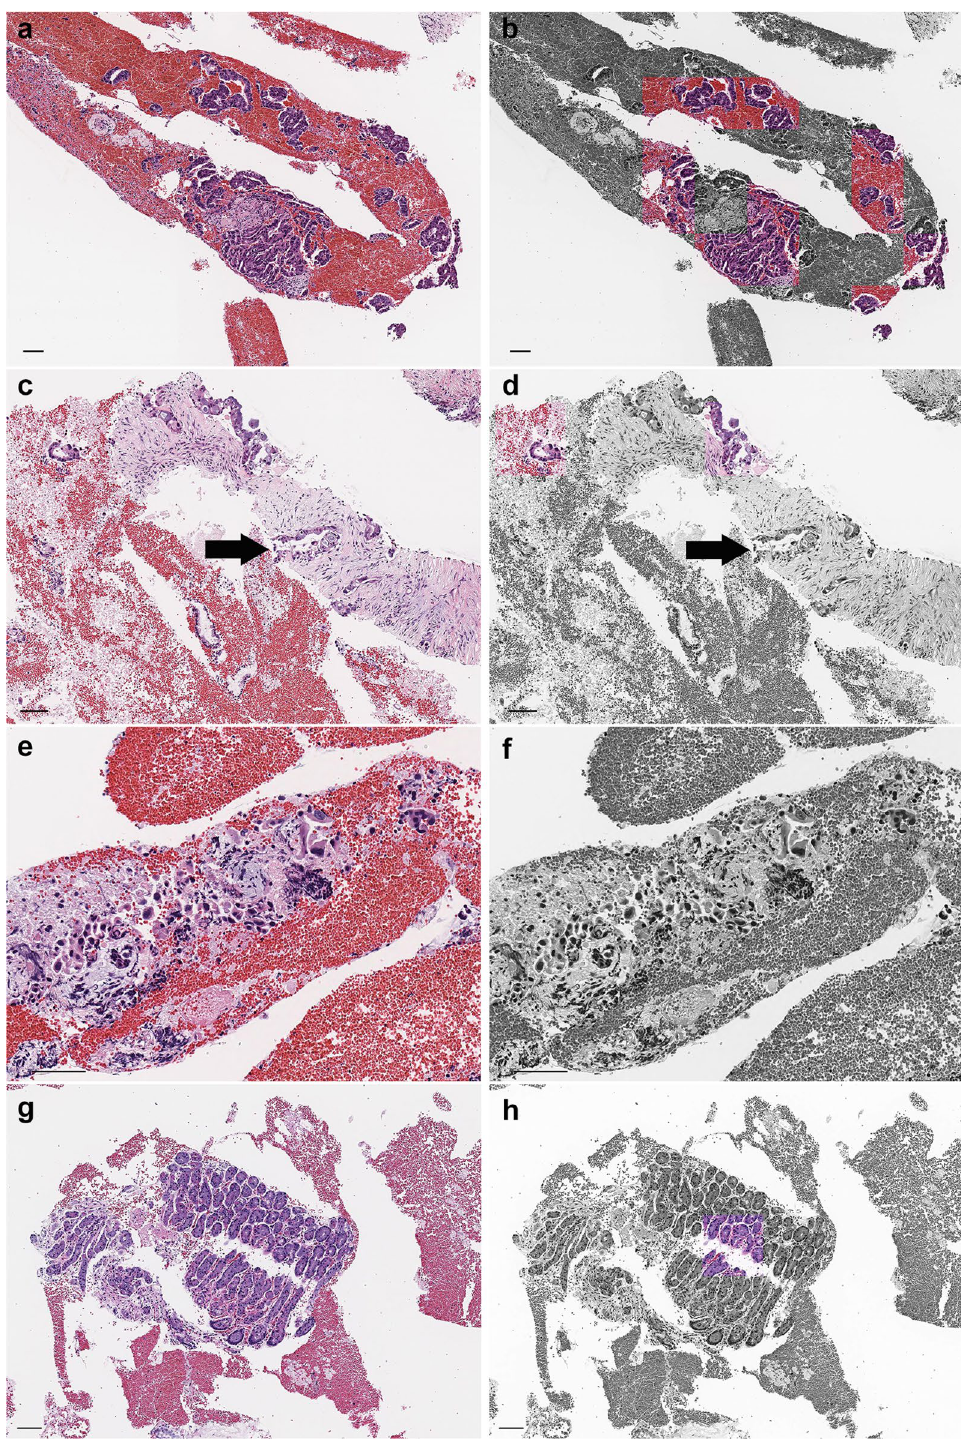
Figure 3. Examples of model prediction outputs for pancreatic ductal adenocarcinoma (PDAC). EUS-FNB samples are mainly composed of fragmented tissues. Our model was able to detect cancer cells selectively among the isolated cells in the specimen ( a , b ). However, the identification of invasive cancer cells (arrow) was not always made accurately ( c , d ). The detection of cancer cells in small cluster areas was difficult ( e , f ). In the false positive case, gastric glands were mislabelled as adenocarcinoma ( g , h ). Scale bars: 100